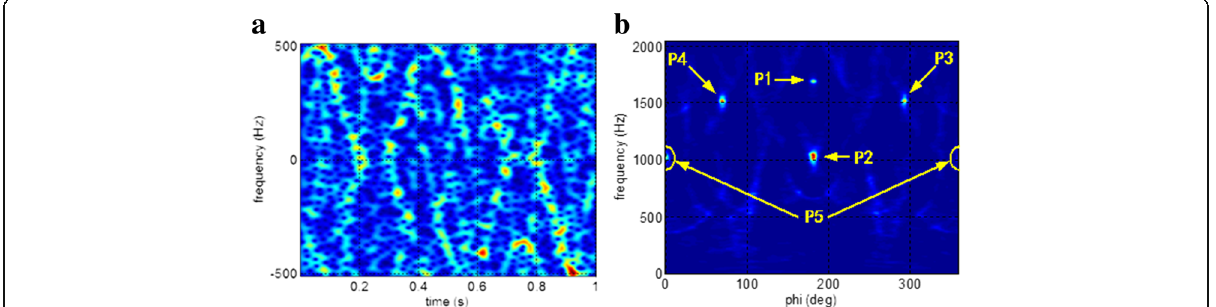
Fig. 10 Results of experiment No. 5. (carrier frequency: 340 GHz, SNR: 3 dB, scattering centers: P1, P2, P3, P4, and P5). a The time-frequency image. b The parameter space